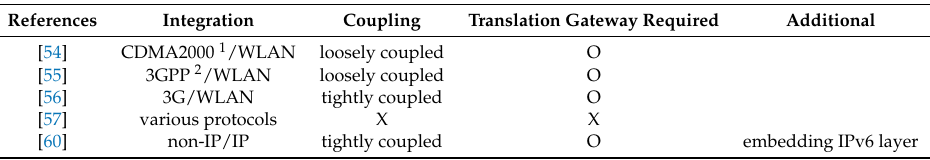
Table 4. The comparison of heterogeneity